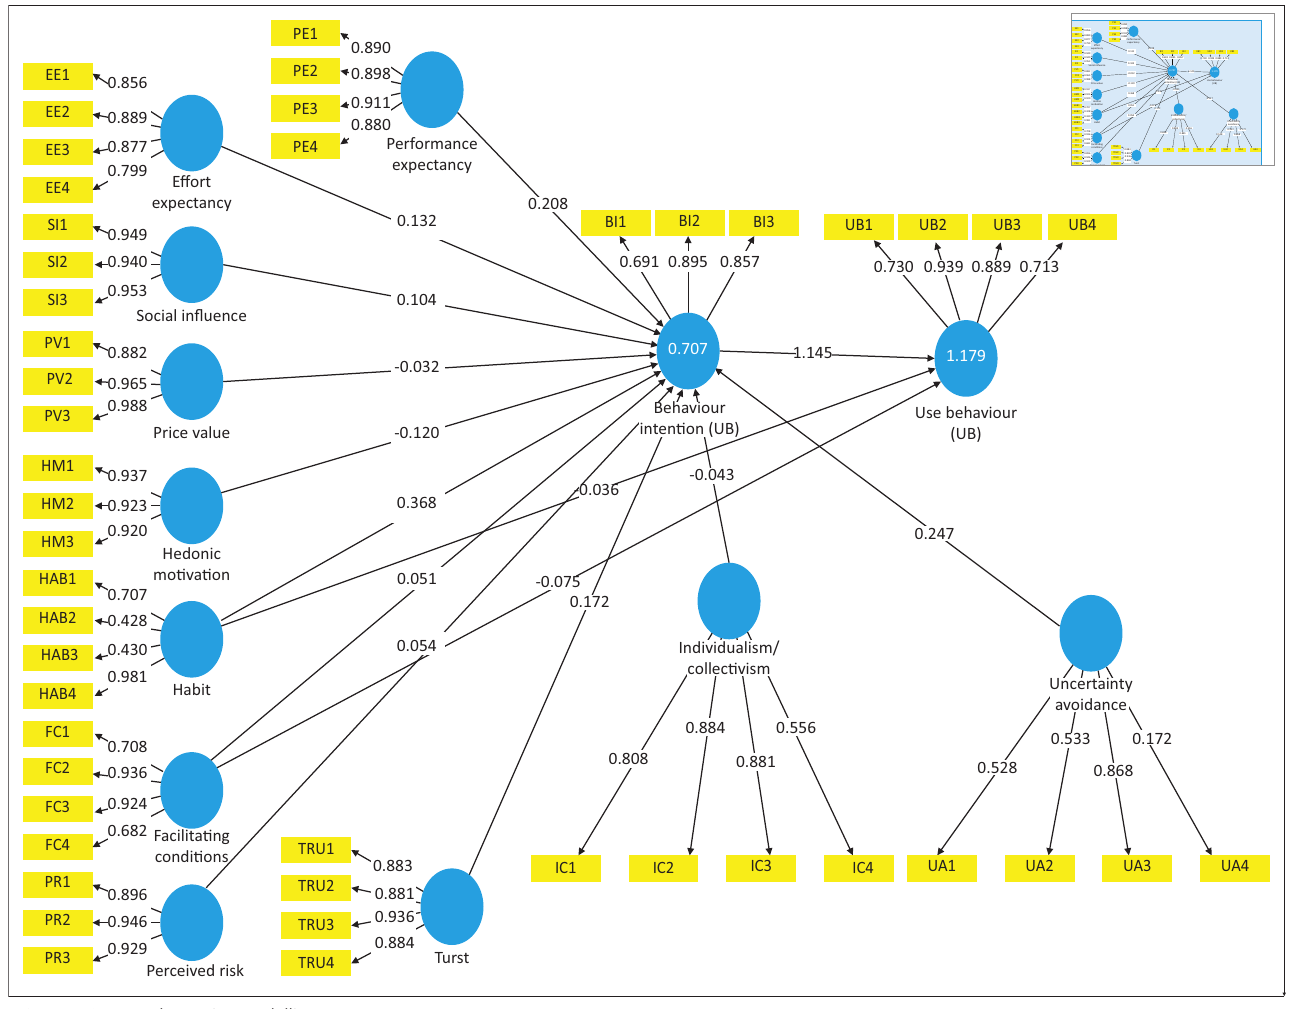
FIGURE 1: Structural equation TABLE 4: Correlation analysis.